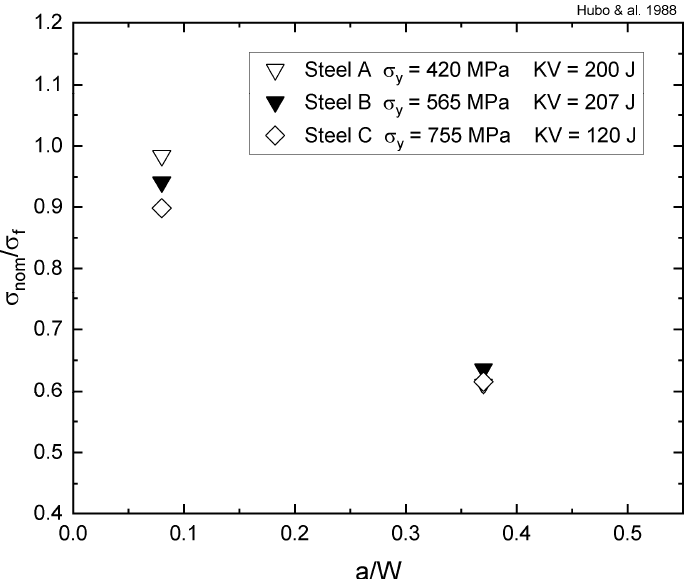
Figure 9. CC(T) test maximum load (nominal stress) values divided by flow stress for three different steels, as a function of relative crack length a/W [10]. steels, as a function of relative crack length a/W [10].